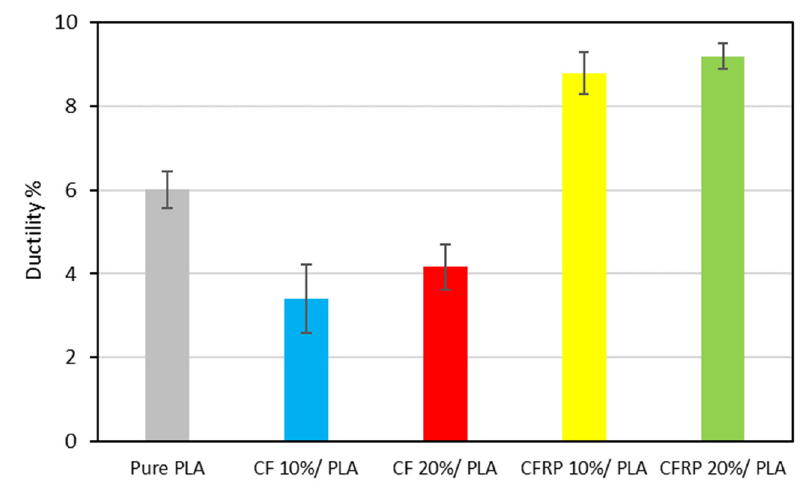
Figure 16. Strain at the failure point.